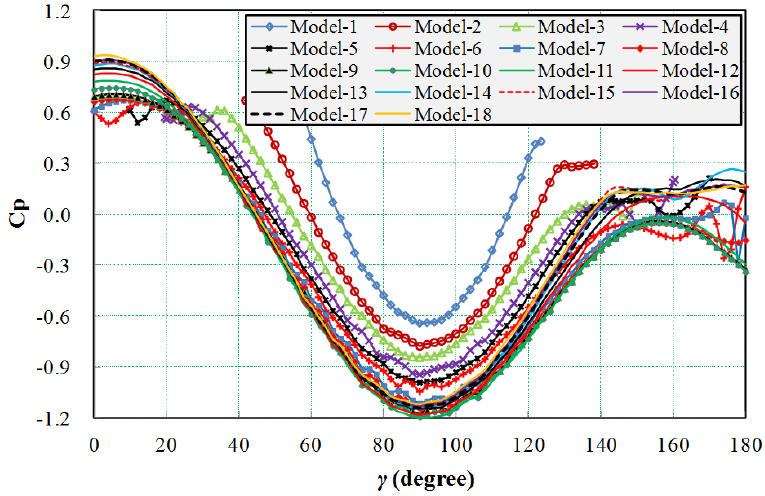
Figure 8. Mean pressure coefficient along the centre meridian of the upper hemisphere (reference height: H ).